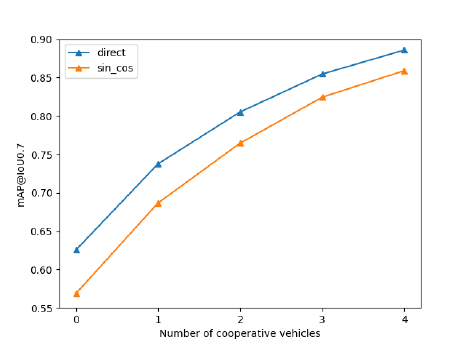
Figure 4. Performance of CIA-SSD with different bounding box target encodings at communcation range 60m. The legend ”dir- ect” indicates the original encoding by the residual of ground truth angle minus the pre-defined anchor angle, where ”sin cos” means the decoupled angle encoding like